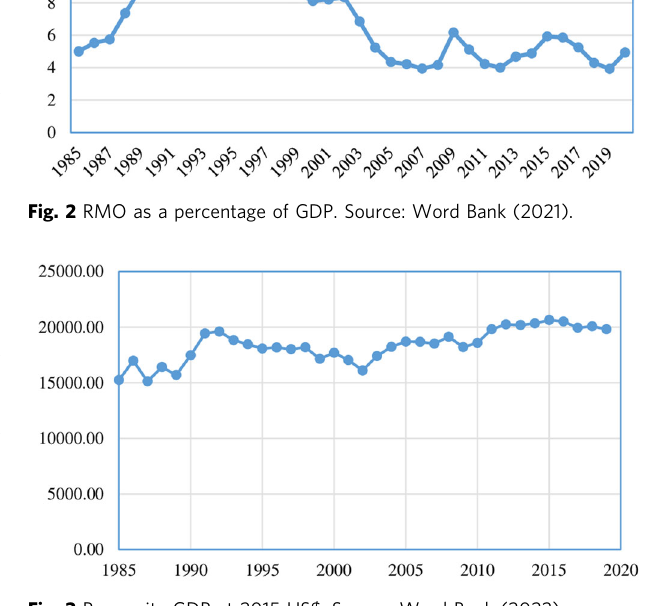
Fig. 3 Per capita GDP at 2015 US$. Source: Word Bank